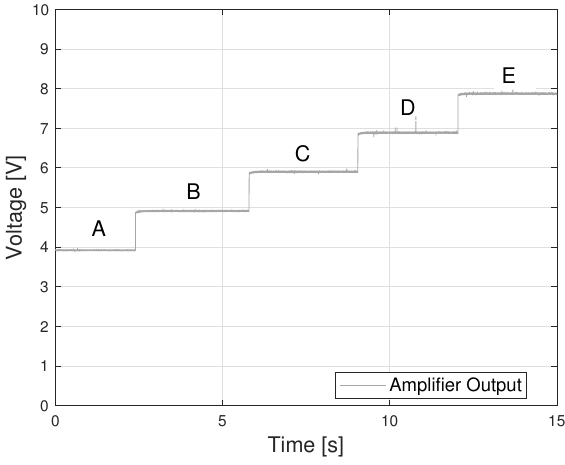
Figure 9. Voltage time history of the staircase test.